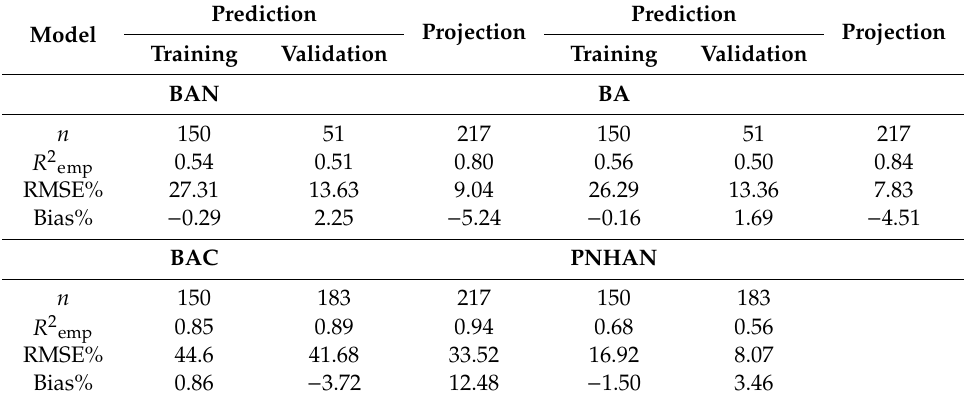
Table 3. Goodness-of-fit measures for models for the basal area of Nothofagus species (BAN, Equations (7) and (9)), basal area of companion species (BAC, Equations (8) and (10)), total basal area (BA), and the proportion of number of Nothofagus species trees (PNHAN, Equation (11)).